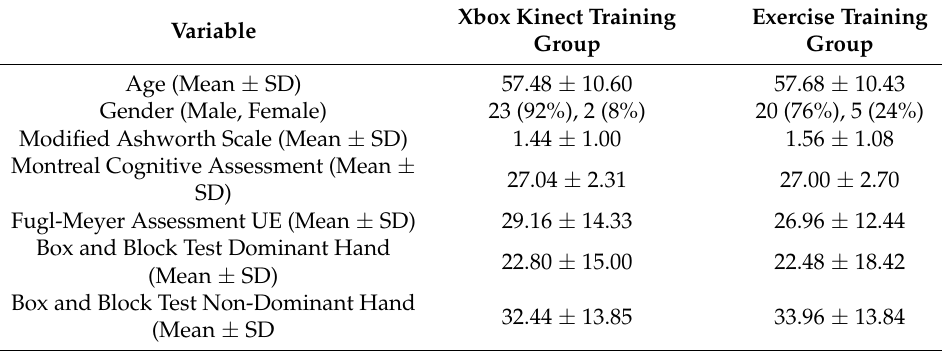
Table 1. Demographics and Baseline data.